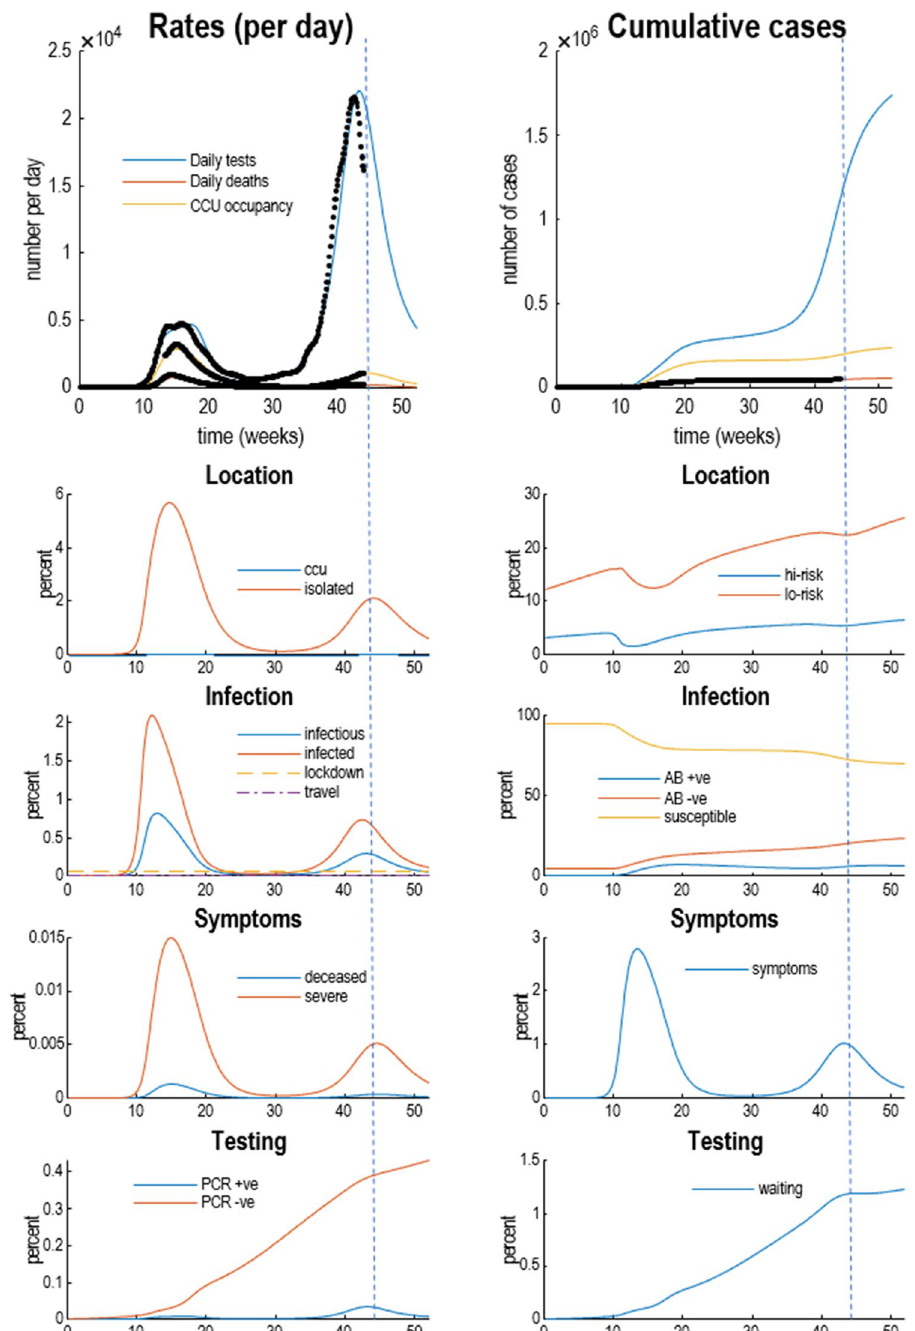
Figure 3. Posterior predictions and underlying latent states. The upper two panels show selected outcomes from the previous figures (black dots): here, daily confirmed cases using PCR testing, daily deaths, and critical care occupancy. The upper left panel shows the rates, while the upper right panel shows the cumulative totals. The remaining panels detail fluctuations in the latent states of the four factors. Each factor has two panels, showing each of the accompanying levels. For clarity, some levels have been omitted because the probabilities of being in any level—of any given factor—sum to one. For a more detailed explanation of what these latent states mean—and how they can be interpreted—please see the Supplementary